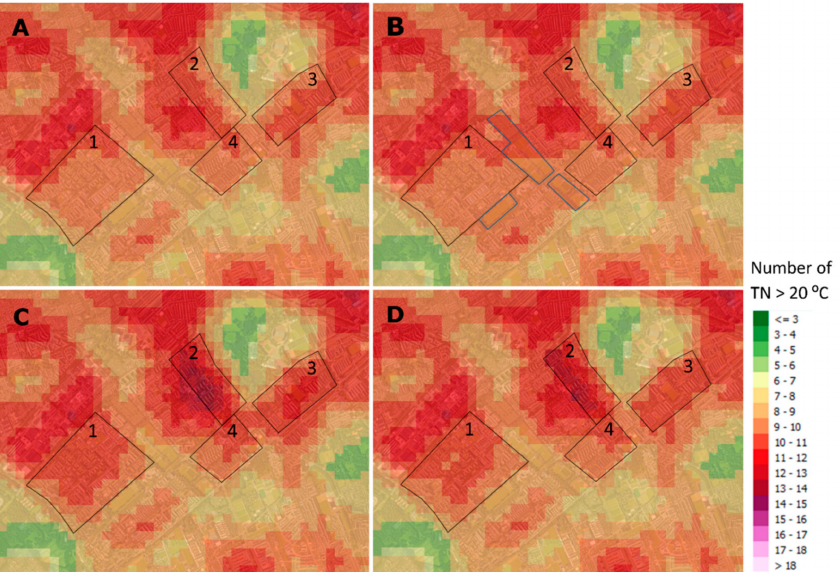
Figure 8. Modeled number of tropical nights per year for the W H climate scenario in 2050 for The Hague Southwest for: ( A ) current housing, ( B ) building on green corridors around the neighborhoods with low- and mid-rise buildings, ( C ) constructing low- and mid-rise buildings on green spaces within the urban neighborhoods, and ( D ) constructing high-rise buildings within the urban neighborhoods to preserve existing green